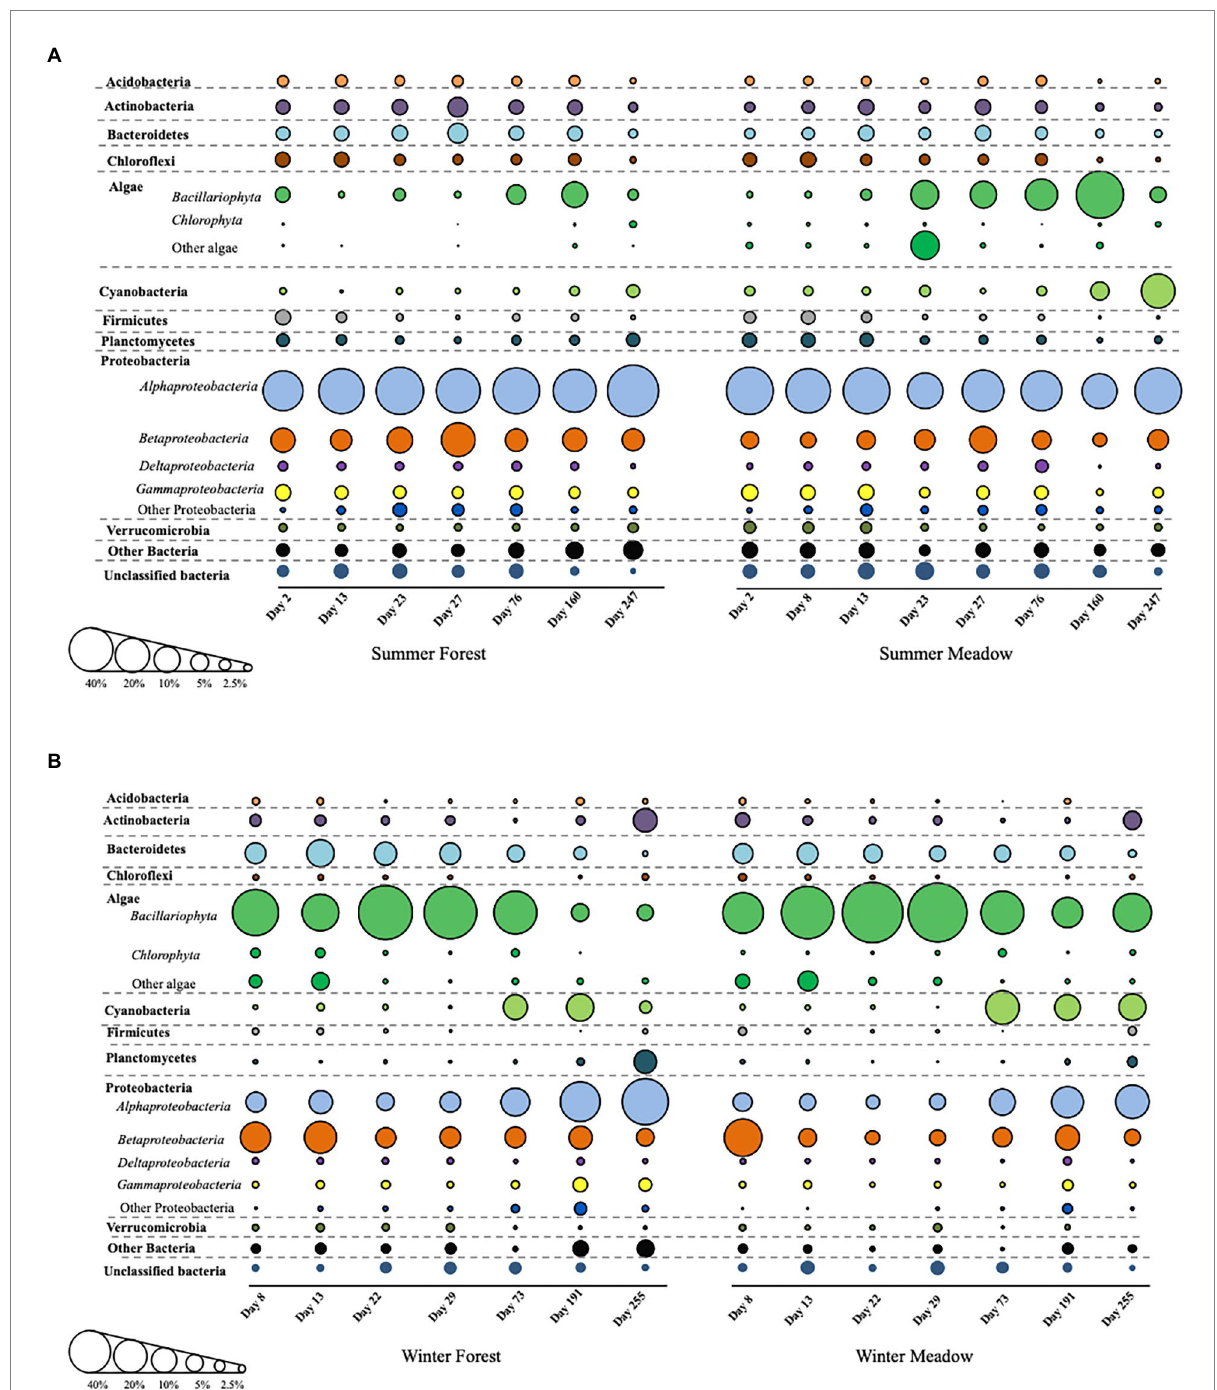
FIGURE 2 The detailed succession of periphyton community composition starting from summer (A) and winter (B) . Bubble sizes are corresponding to relative abundance of each